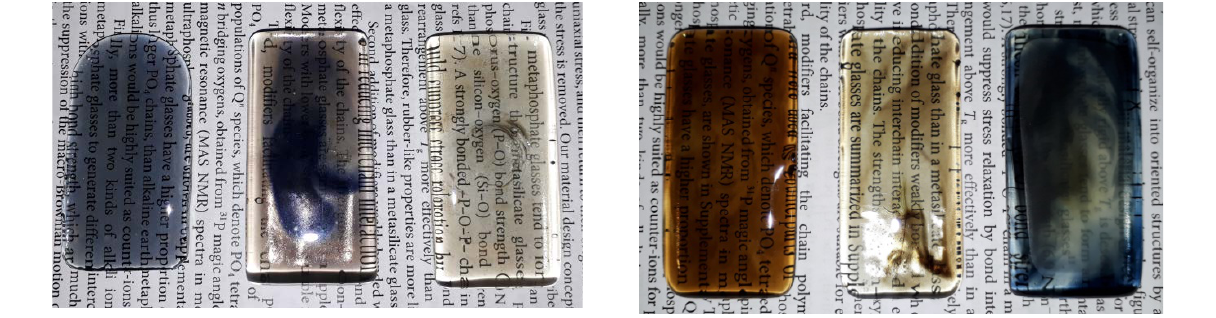
Fig. 5 Samples consisting of 12.5% slag melted at different Fig. 6 Samples consisting of 15% slag, without the addition of B 2 O 3 , temperatures: 1150°C, 1250°C, and 1350°C, respectively. with the addition of 10% B 2 O 3 and 20% B 2 O 3 , respectively. For the samples containing fly ash, transparent samples with a maximum concentration of 35% of fly ash